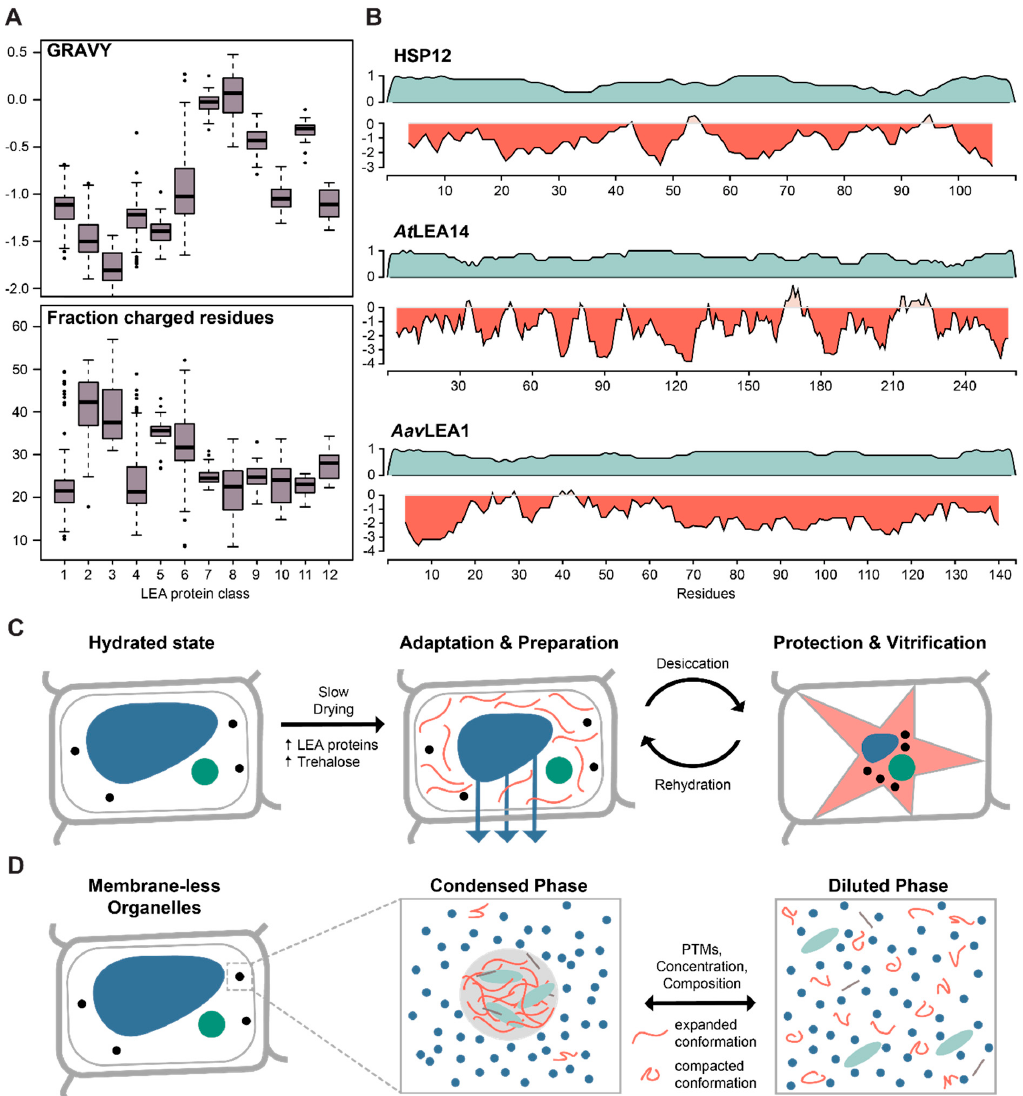
Figure 1. Late Embryogenesis Abundant (LEA) proteins and the role of intrinsically disordered proteins (IDPs) in desiccation and liquid–liquid phase separation. ( A ) Boxplot of the Grand Average of Hydropathy (GRAVY) and the fraction of charged residues (DEKR) calculated for the 12 LEA protein classes, based on statistical analysis of physico-chemical properties and amino acid usage [30]. Adapted and modified with permission from http://forge.info.univ-angers.fr/~gh/Leadb/index.php. ( B ) Disorder prediction